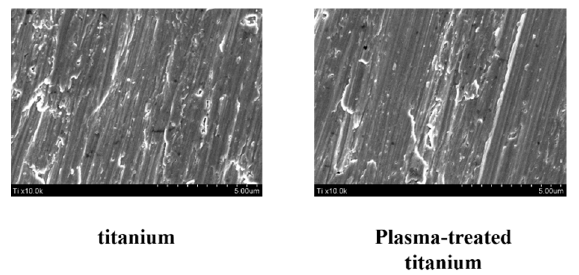
Figure 1. Surface morphology of titanium and plasma-modified titanium by SEM. SEM disclosed no structural changes on the titanium disk surface after plasma